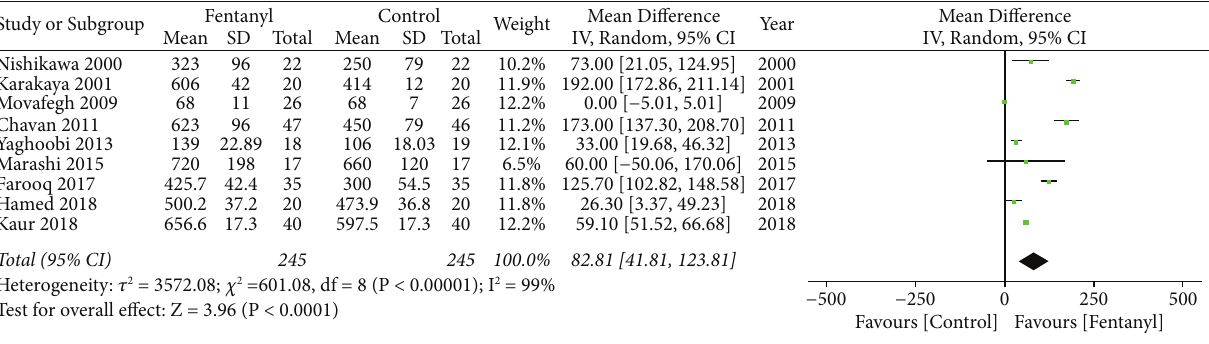
Figure 7: Meta-analysis of the duration of sensory anesthesia between fentanyl and control